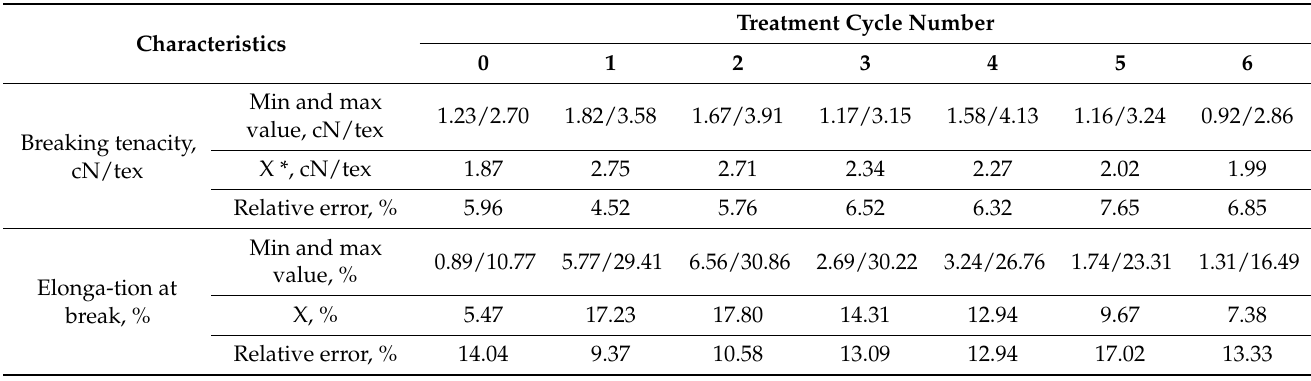
Table 1. Tensile characteristics of investigated wool